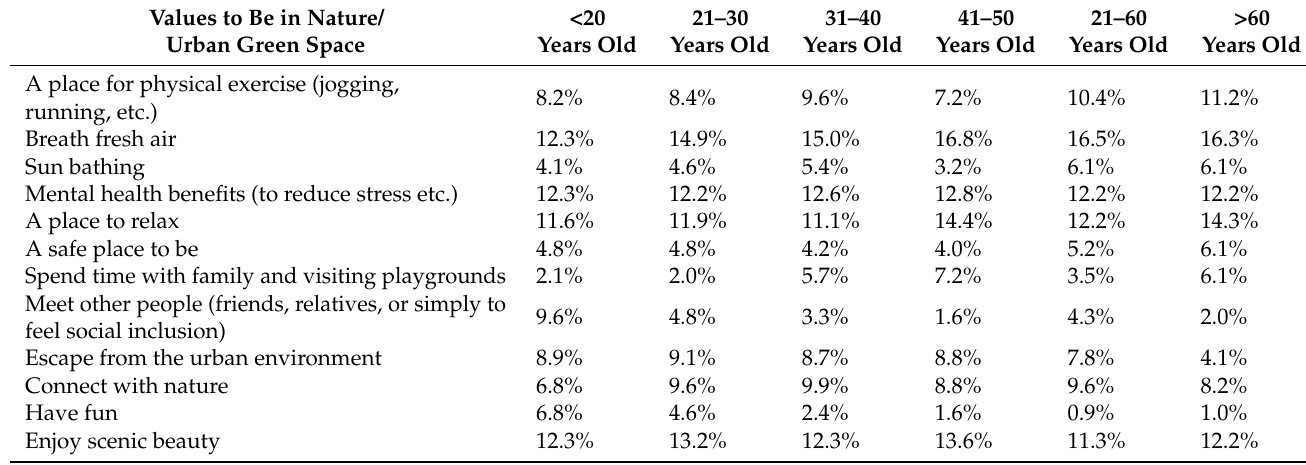
Table 3. Perceived personal benefits of UGS by Moscow residents of different ages ( n =